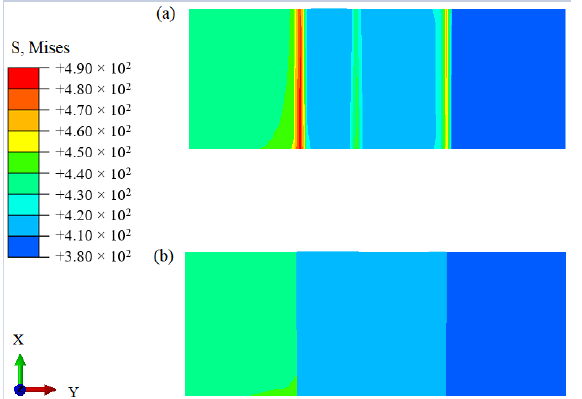
Figure 6. Numerical simulation results under an axial load: ( a ) continuous transition model, ( b ) sandwich model.